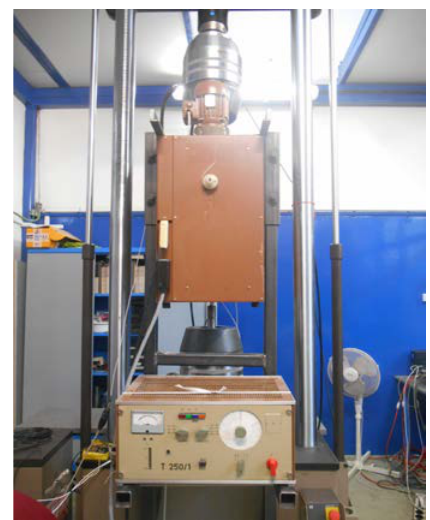
Fig. 4 MTS 500B with TiraTest 201 chamber for DMTA.